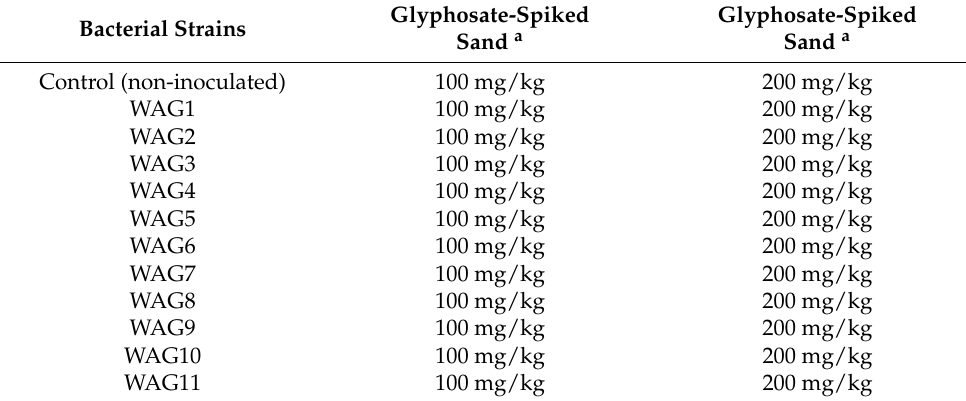
Table 1. Summary of experimental